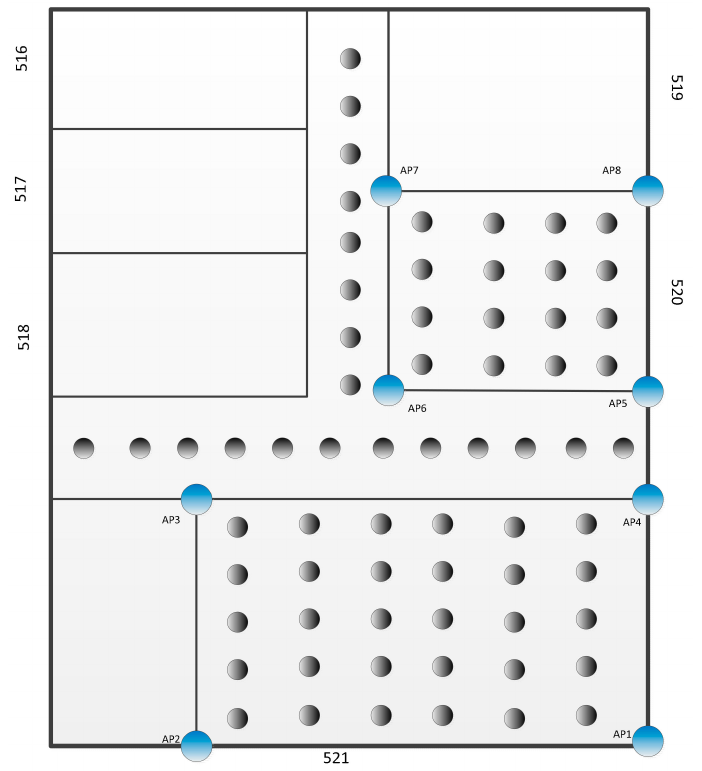
Figure 3. Nodes distribution map of indoor localization experiment area. (